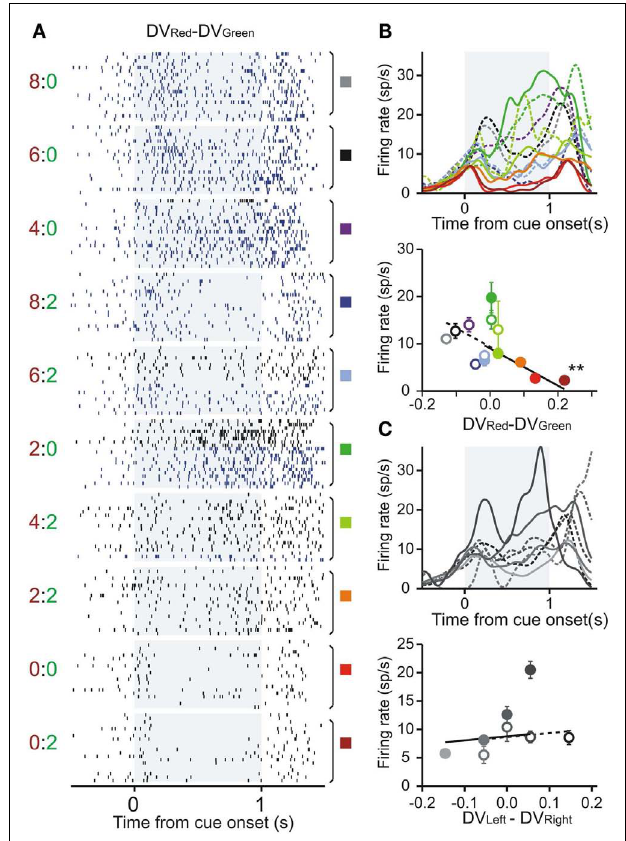
FIGURE 3 | Example neuron in the ventral striatum encoding the difference in the temporally discounted values for the red and green target. (A) Raster plots sorted according to the difference in the DVs between red and green targets. (B,C) Spike density functions and average firing rates during the cue period sorted by the difference in the DVs between red and green targets (B) and between left and right targets (C) . Same format as in Figures 2A–C